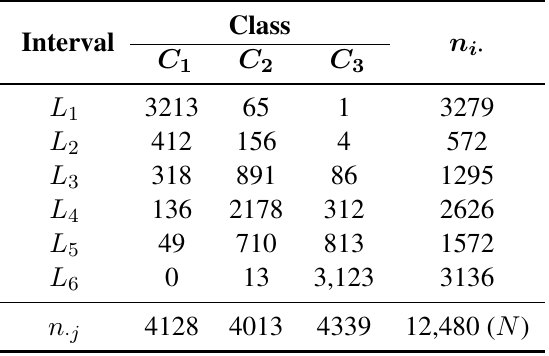
class contained in each interval L i